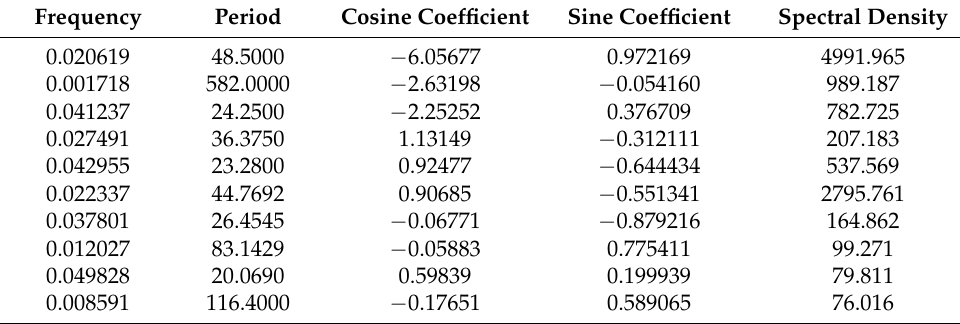
Table 1. First 10 frequencies of NEK Sava river reservoir levels.